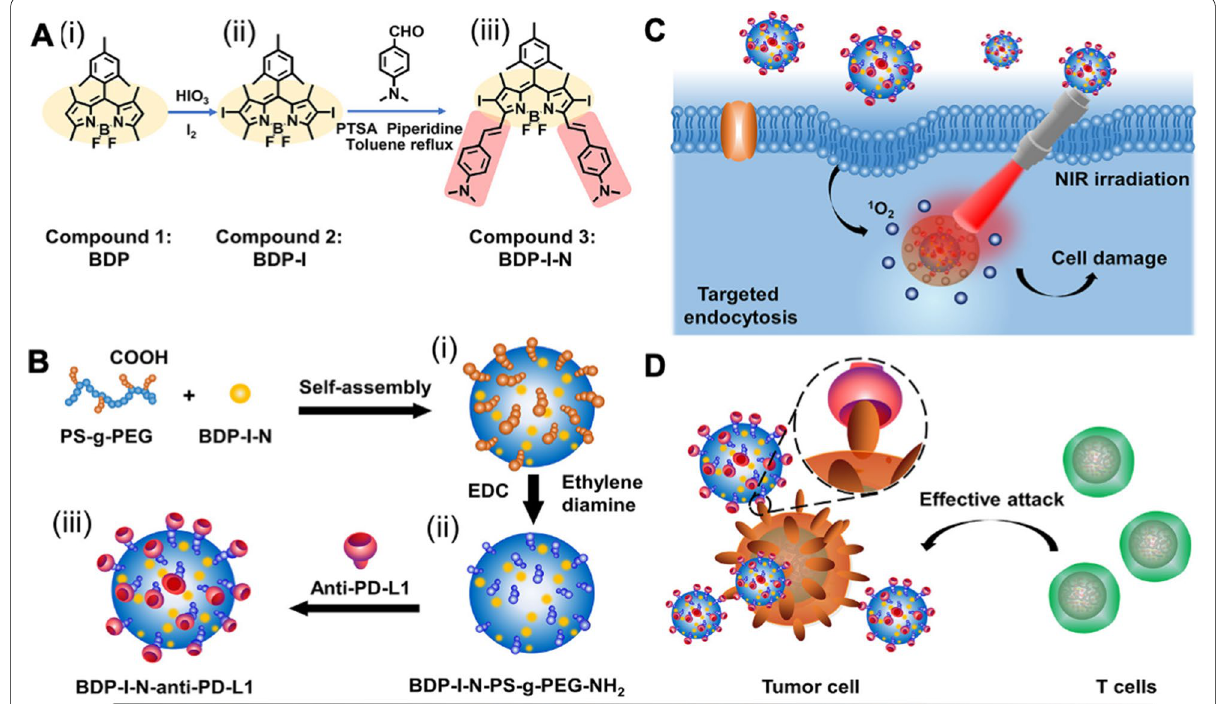
Fig. 8 A and B Synthesis of boron-dipyrromethene compounds and subsequent assembly of nanocarriers functionalized with cell death-ligand 1 (PD-L1) monoclonal antibody. C and D Schematic of the BDP-I-N-anti-PD-L1-mediated phototoxicity and immune efficacy for tumor cells. Reprinted with permission, [319] https:// doi. org/ 10. 1021/ acsna no. 0c053